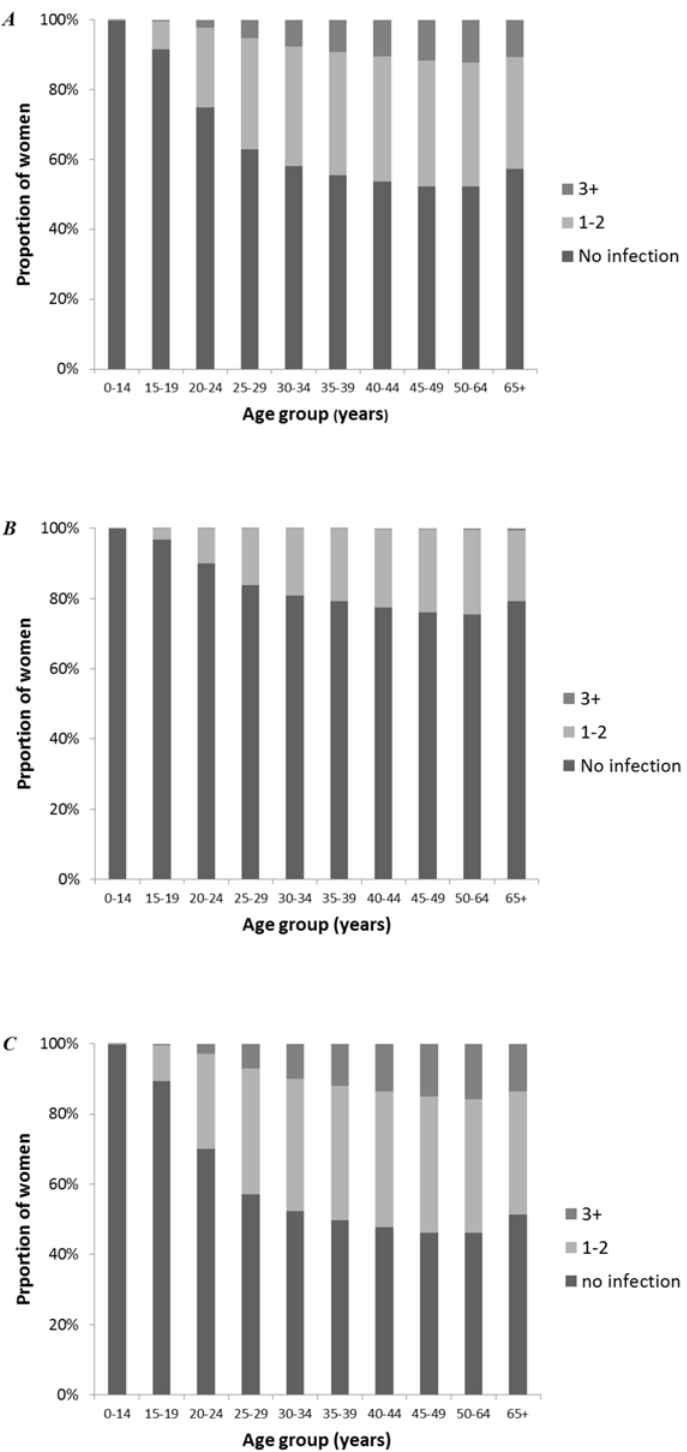
Figure 3. Predicted cumulative number of HPV-16 (A) , HPV-18 (B) , and HPV-16/-18 (C) infections in women. The proportion of women with no lifetime infections slightly increased in women aged 65+